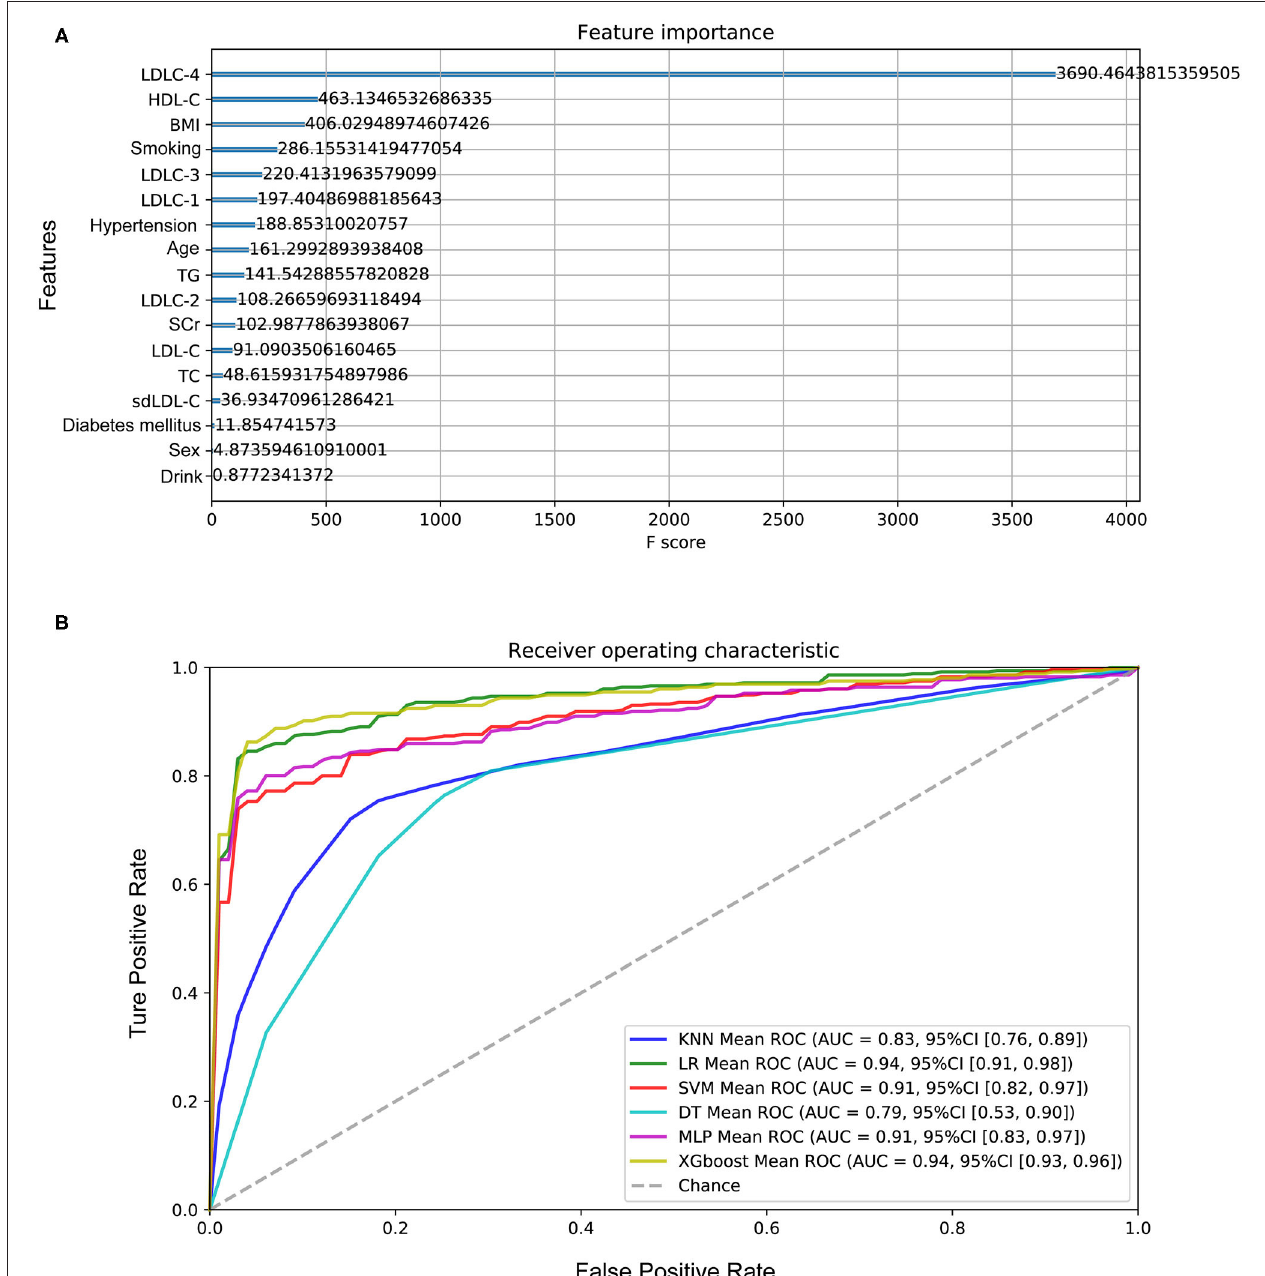
FIGURE 5 | Performance of the models to predict CAD development. (A) The importance of features in model construction, including clinical features and laboratory indexes. (B) The ROC curves of six models. CAD, coronary artery disease; LDL-C, low-density lipoprotein cholesterol; HDL-C, high-density lipoprotein cholesterol; BMI, body weight index; TG, triglyceride; SCr, serum creatinine; TC, total cholesterol; sdLDL-C, small and dense